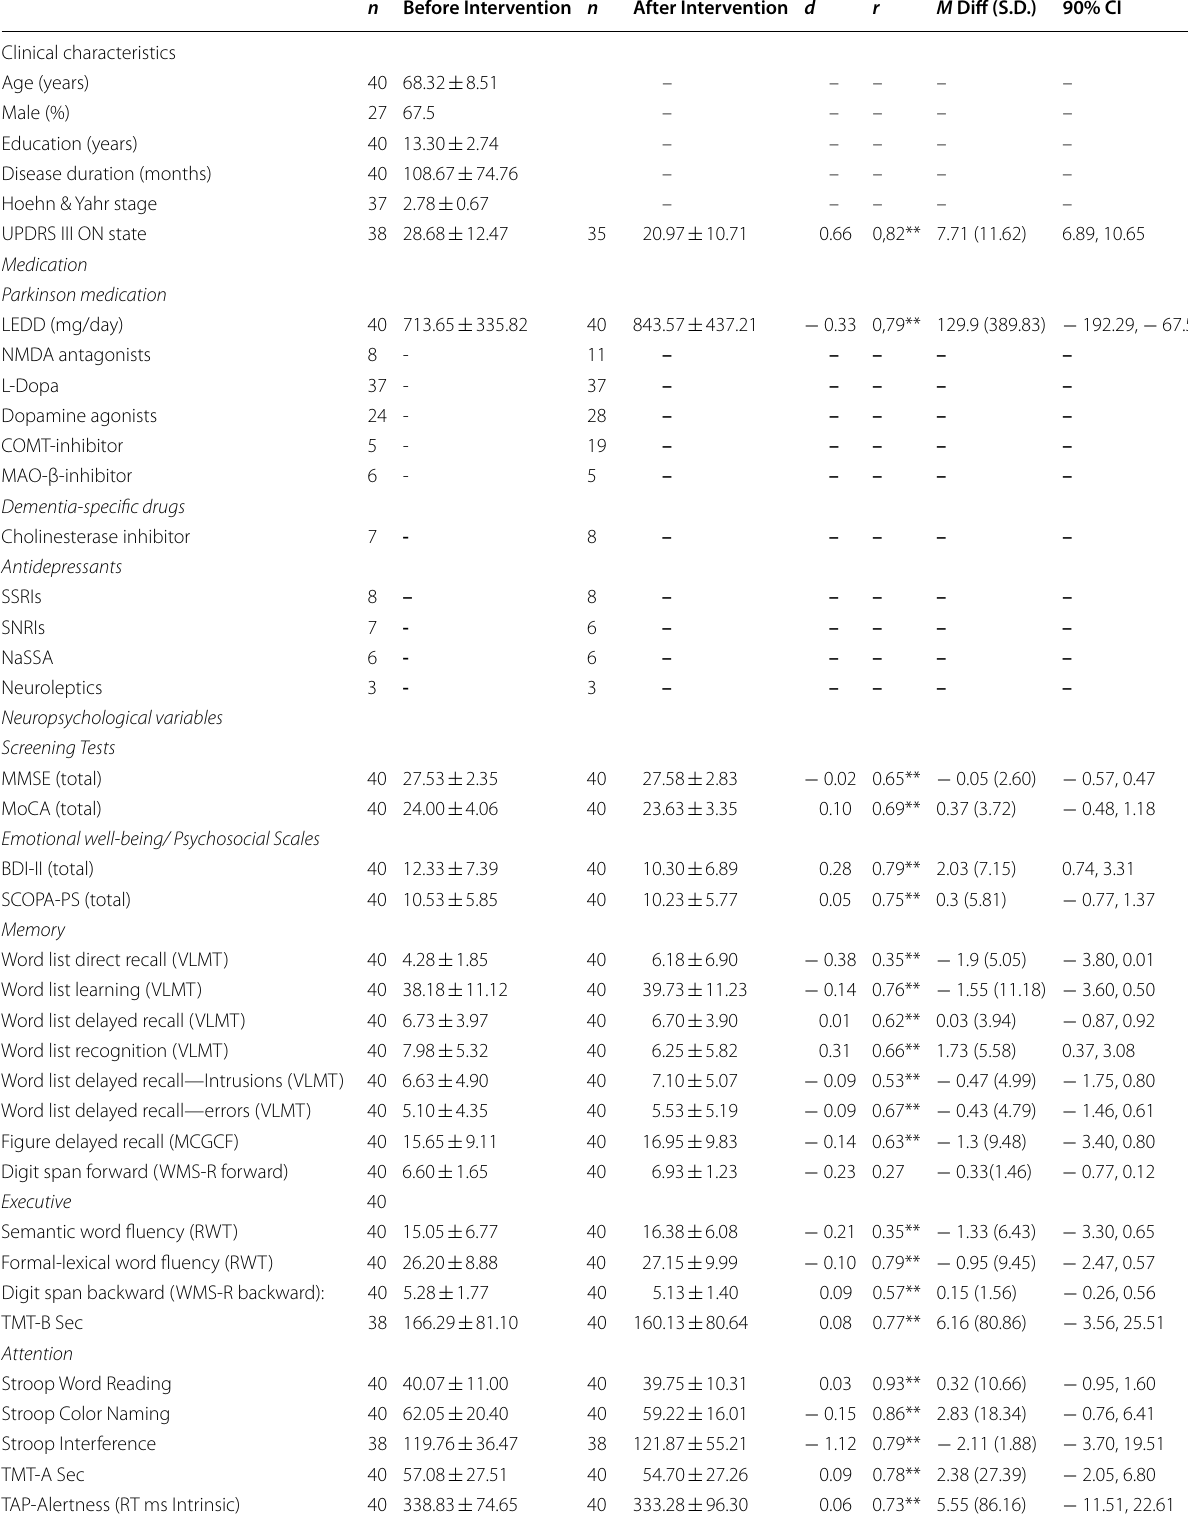
Table 2 Demographics, clinical characteristics, test–retest reliability, practice effects, and reliable change indices n Before Intervention